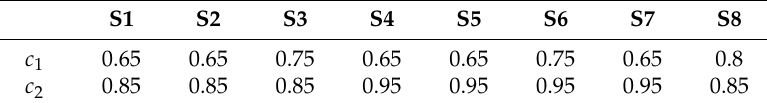
Table 2. The parameters of the proposed algorithm for each